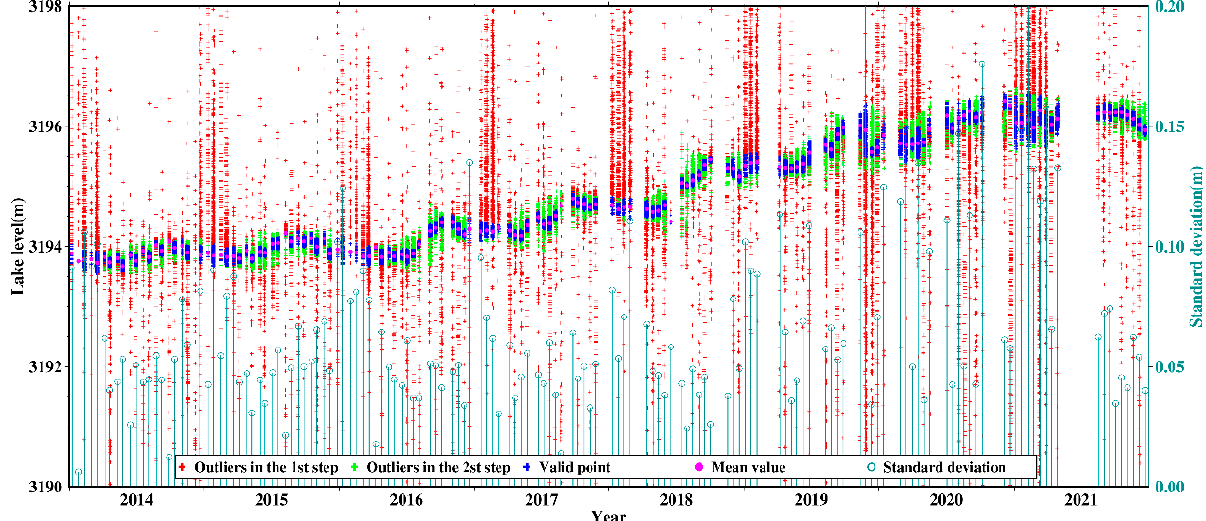
Figure 5. Example of outlier detection in the case of SARAL observations over LQ.